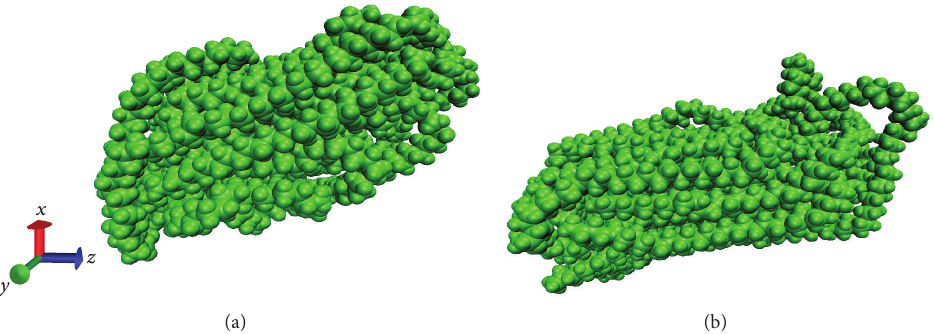
Figure 2: The final structures of the polyethylene chain (a) of the 1ns relaxation simulation and (b) of the subsequent 2 ns CMD simulation.